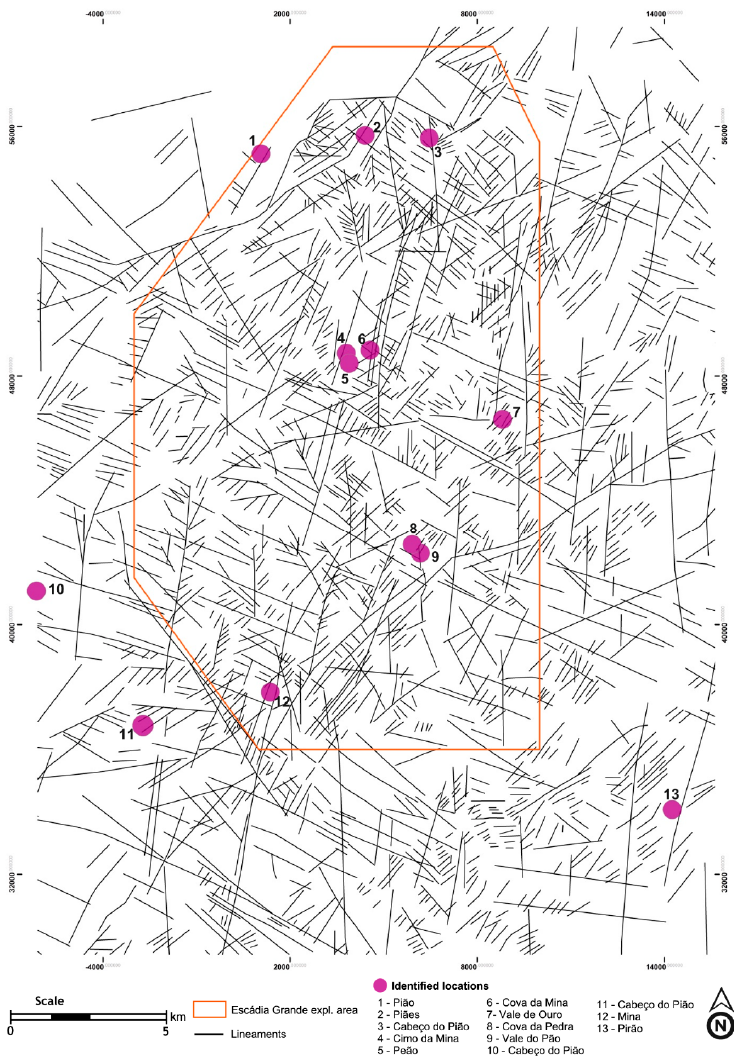
Figure 20. Lineament map and locations with particular toponymy (based on the 1:25,000 scale Portuguese Military Cartography).